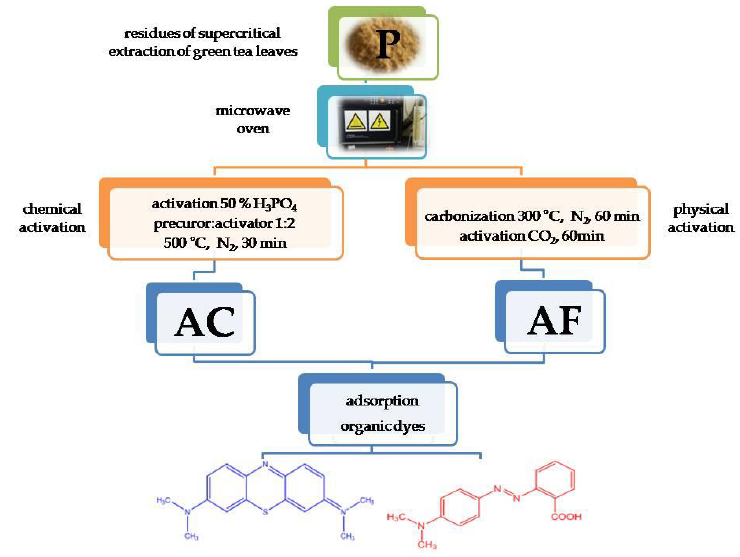
Figure 1. Scheme of the activated carbons preparation.